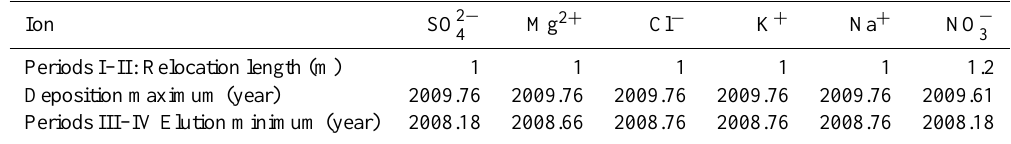
Figure 6. Annual precipitation cycle at Longyearbyen airport and Ny-Ålesund for the period 2007–2011 (left) and monthly precipitation amount at the stations and snow accumulation at Lomonosovfonna given by the LF-syn core (right). Table 4. Minimum relocation length estimated for each ion measured in the LF-11 ice